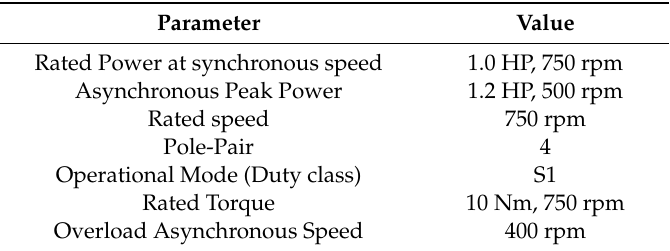
Table 4. Design parameters for all types.